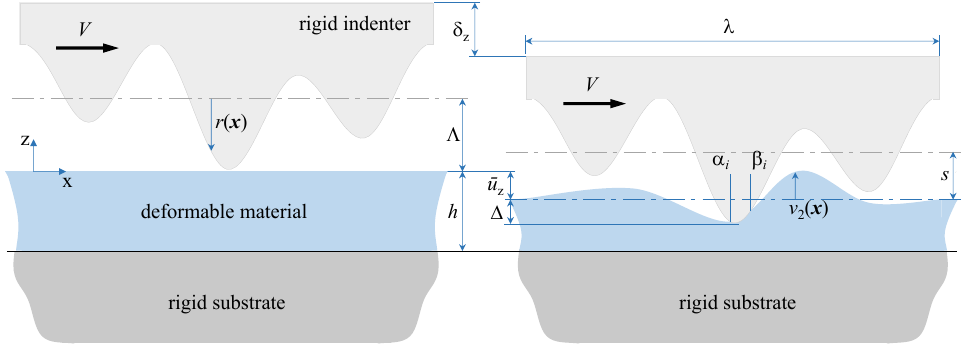
Figure 1. The sliding contact between a rigid rough profile and a deformable layer of thickness h backed onto a rigid substrate.